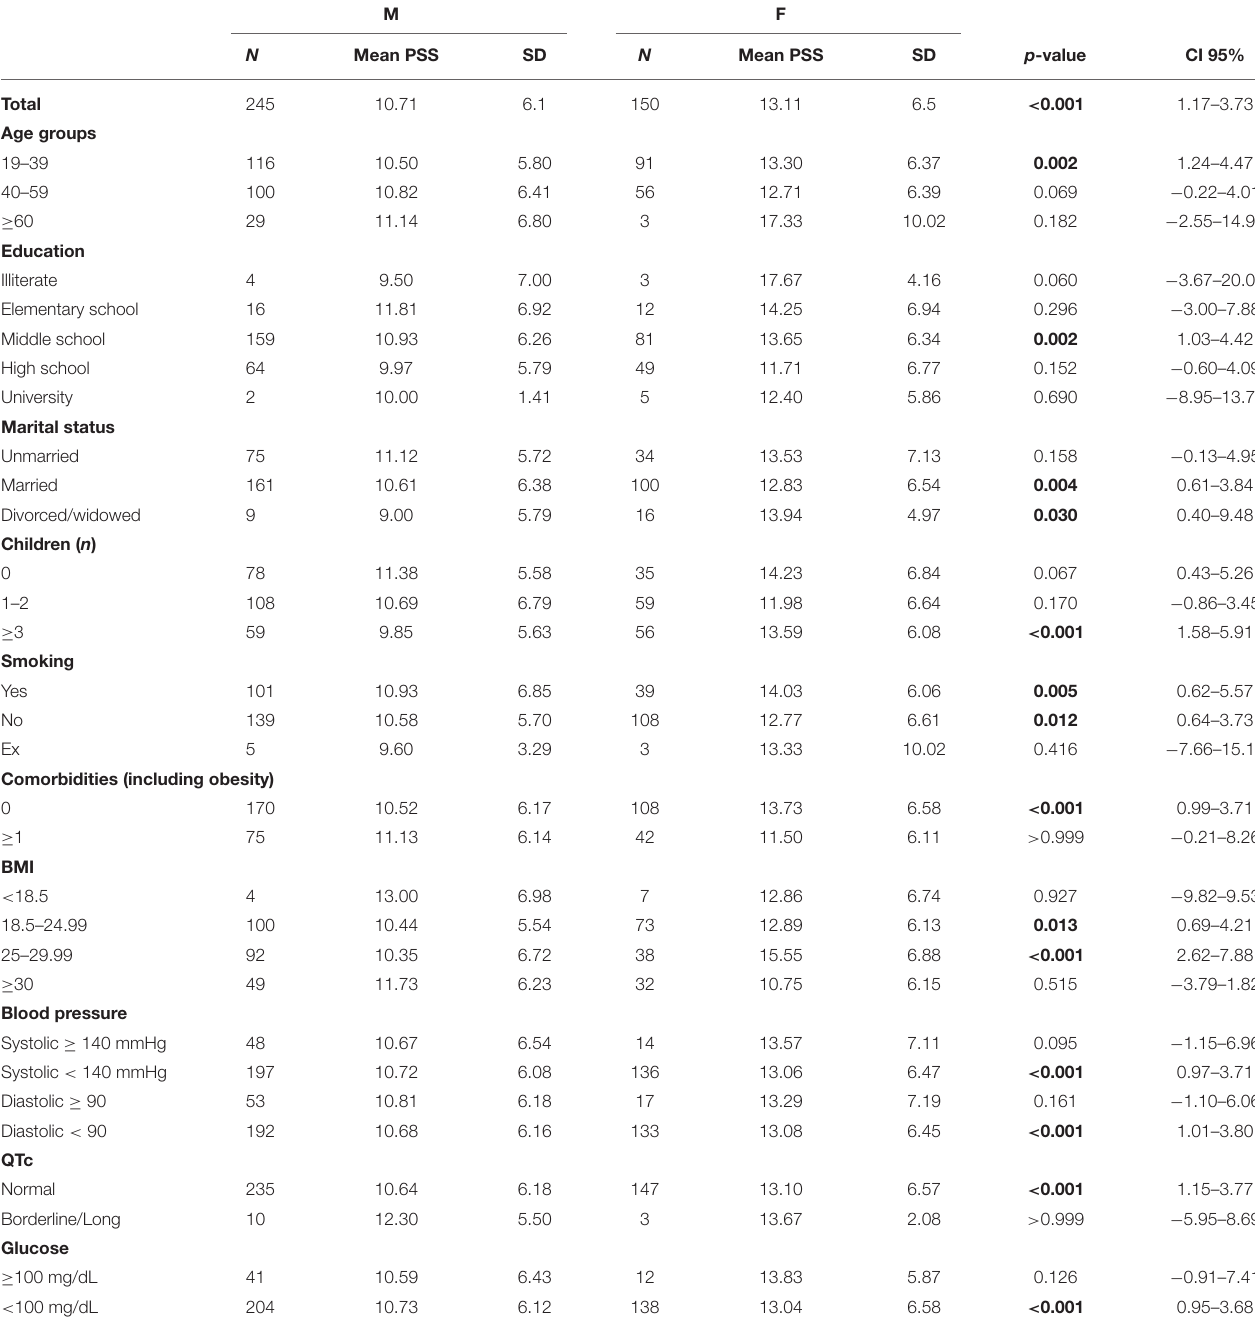
TABLE 3 | Mean difference in perceived stress between genders, according to sociodemographic, lifestyle, and health